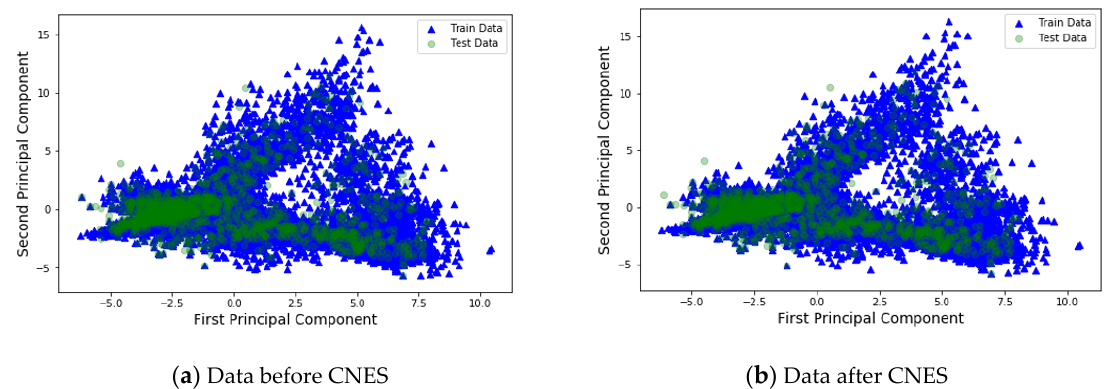
Figure 14. Principal component analysis (PCA) plots for two schemes: ( a ) before and ( b ) after applying the CNES. Green points are test data, and blue points are training data.